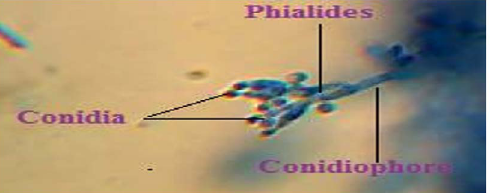
Fig. 1. A microscopic picture of Penicillium